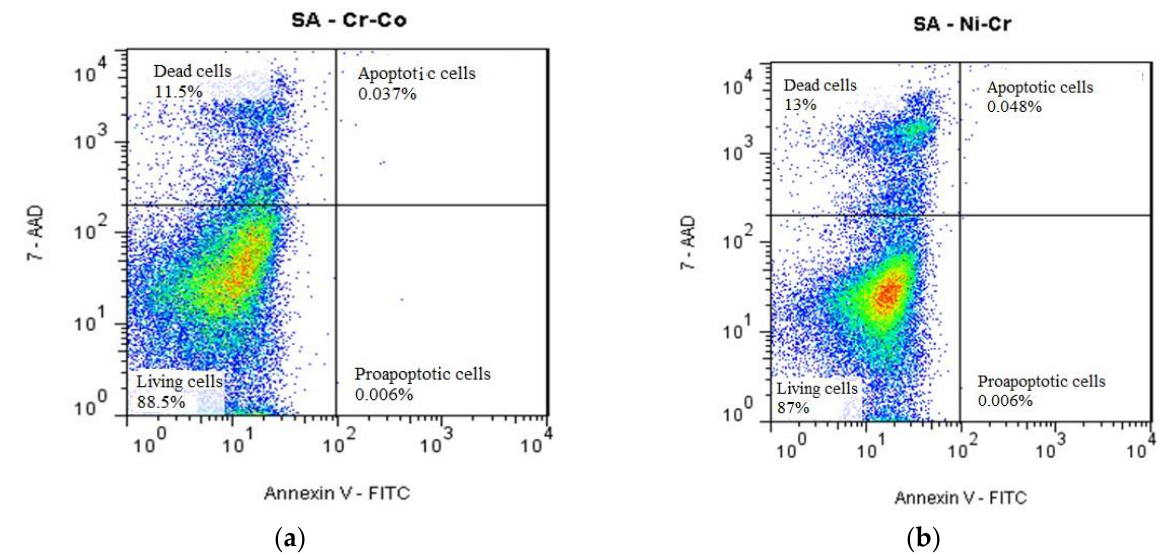
Figure 13. The process of apoptosis and cell viability in monkey renal cell cultures, recorded in continuous flow of cells at the flow cytometer, under the conditions of their treatment with artificial saliva and ionic elutes, from incubation of Cr-Co ( a ) and Ni-Cr ( b ) with artificial saliva.